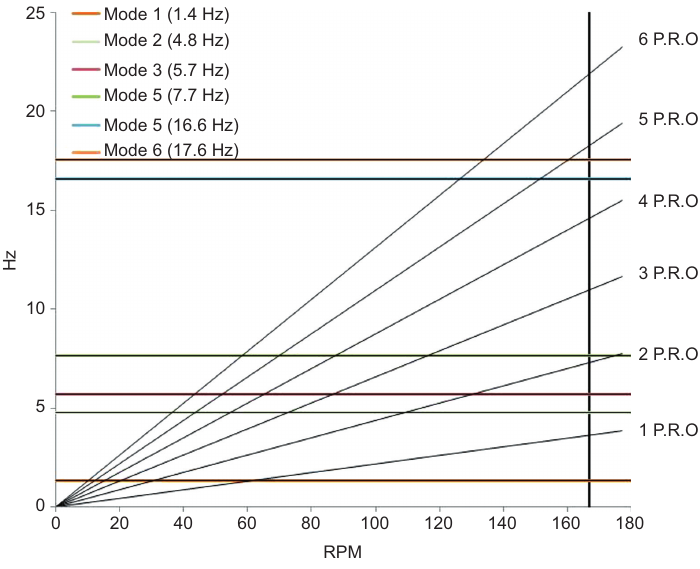
Figure 12 Campbell diagram to check resonance possibility.